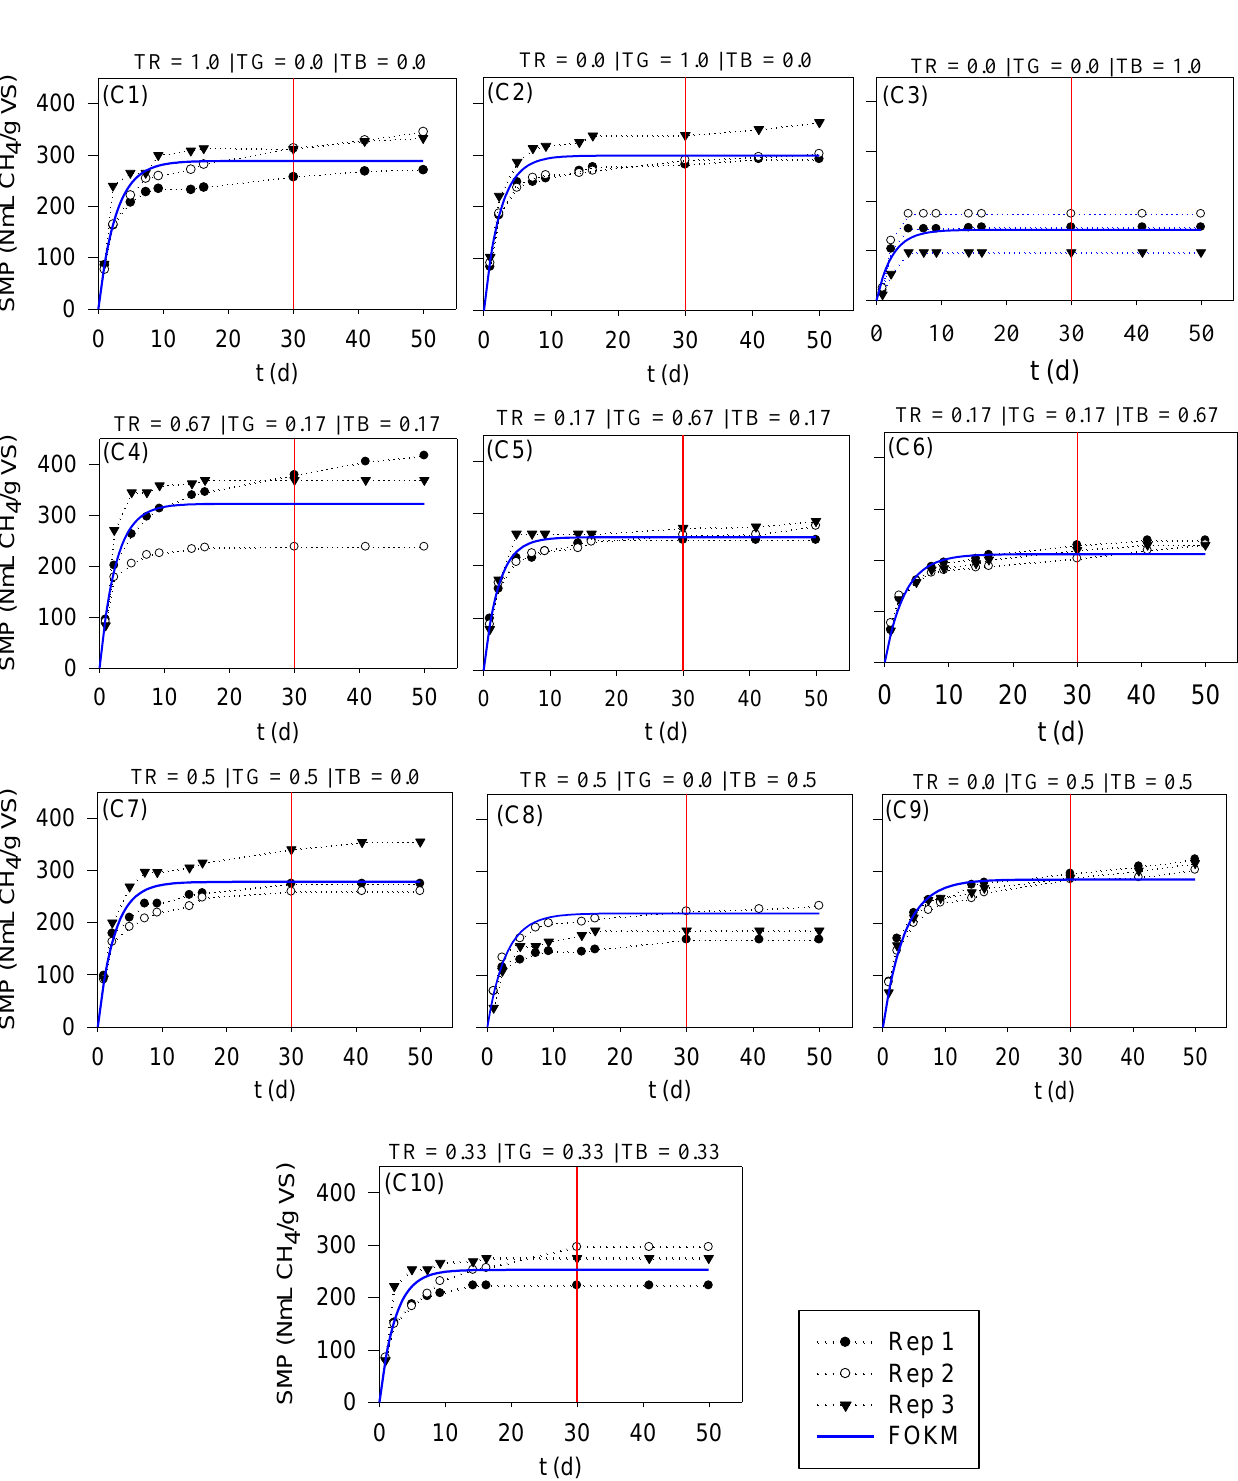
Figure 3. Cumulative specific methane produced though anaerobic co-digestion, over time (days), from different mixtures of RT + GT + TB, considering the following operating conditions: SIR = 0.5; VSt = 20 g/L; WV = 20%; Nu = Y; Inc = N. Table 4. Parameters of the first-order kinetic model corresponding to each experiment of the mixture design and respective experimental BMP.